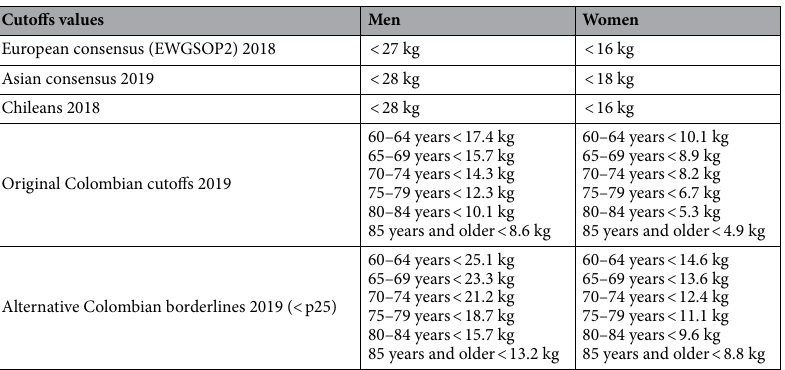
Table 5. Cuttoff values for handgrip dynamometry to measure dynapenia by European and Asian consensus, Chilean and Colombian proposals. European consensus EWGSOP2 2018: European Working Group on Sarcopenia in Older People update in 2018 5 . Asian consensus 2019 11 . Chileans 2018: Reference values of handgrip dynamometry in older Chileans 13 . Original Colombian cutoffs 2019: reference cutoffs for handgrip strength among older adults 17 . Alternative Colombian borderlines2019 (< p25): values lower than the 25-percentile taken from Ramirez-Velez et al. 17